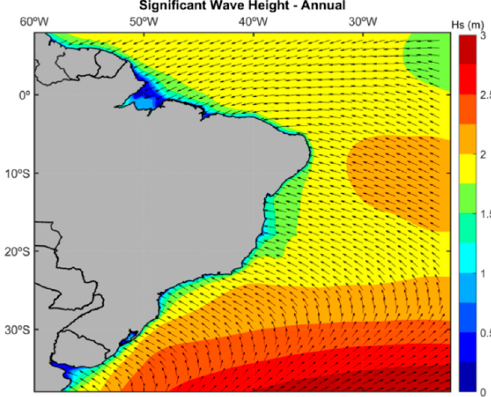
Figure 3. Annual mean H s (m) and θ m ( ◦ ), for Brazil. The distribution of the climatological annual means of 𝐻 (cid:3046)(cid:3050) and 𝜃 (cid:3040)(cid:3050) , and 𝐻 (cid:3046)(cid:3046) and 𝜃 (cid:3040)(cid:3046) , are shown in Figure 4. The differences between the wind sea- and swell-related parameters are easily noticeable. While the mean 𝐻 (cid:3046)(cid:3046) reaches 2.5 m, with most of the offshore region ranging from 1.5 m and 1.75 m, the mean 𝐻 (cid:3046) (cid:3050) does not exceed 1.5 m.